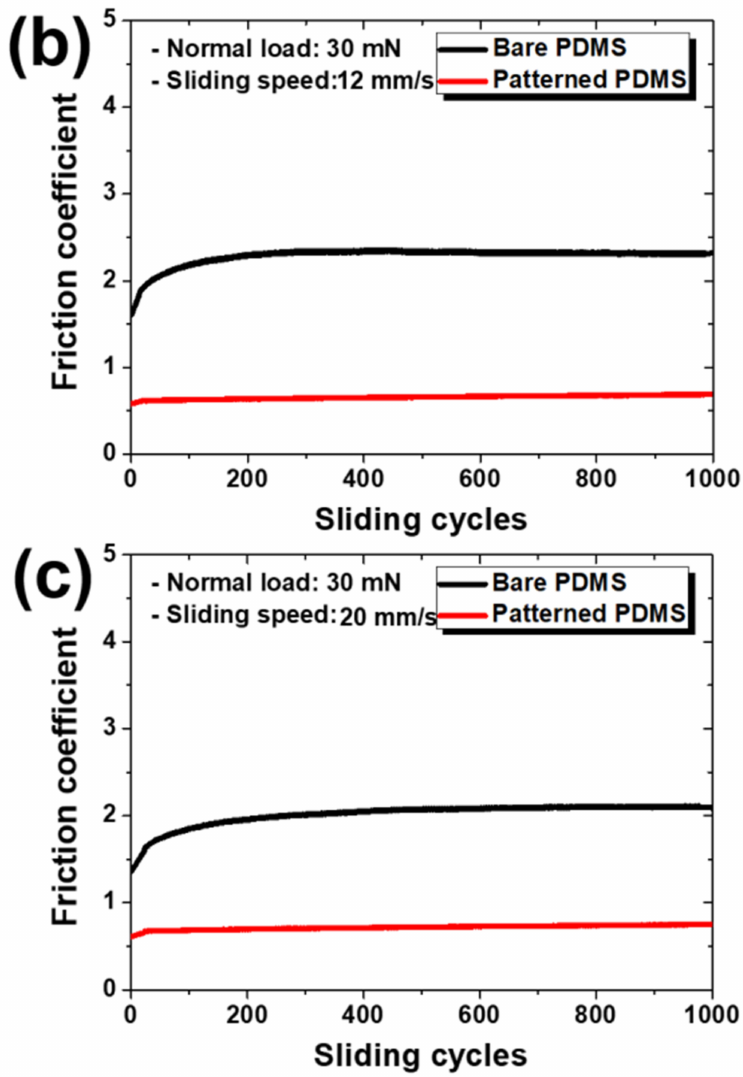
Figure 5. Variations in friction coefficients according to sliding cycles at sliding speeds of ( a ) 4 mm/s, ( b ) 12 mm/s, and ( c ) 20 mm/s under a normal load of 30 mN for bare PDMS and micro/nanopatt- erned